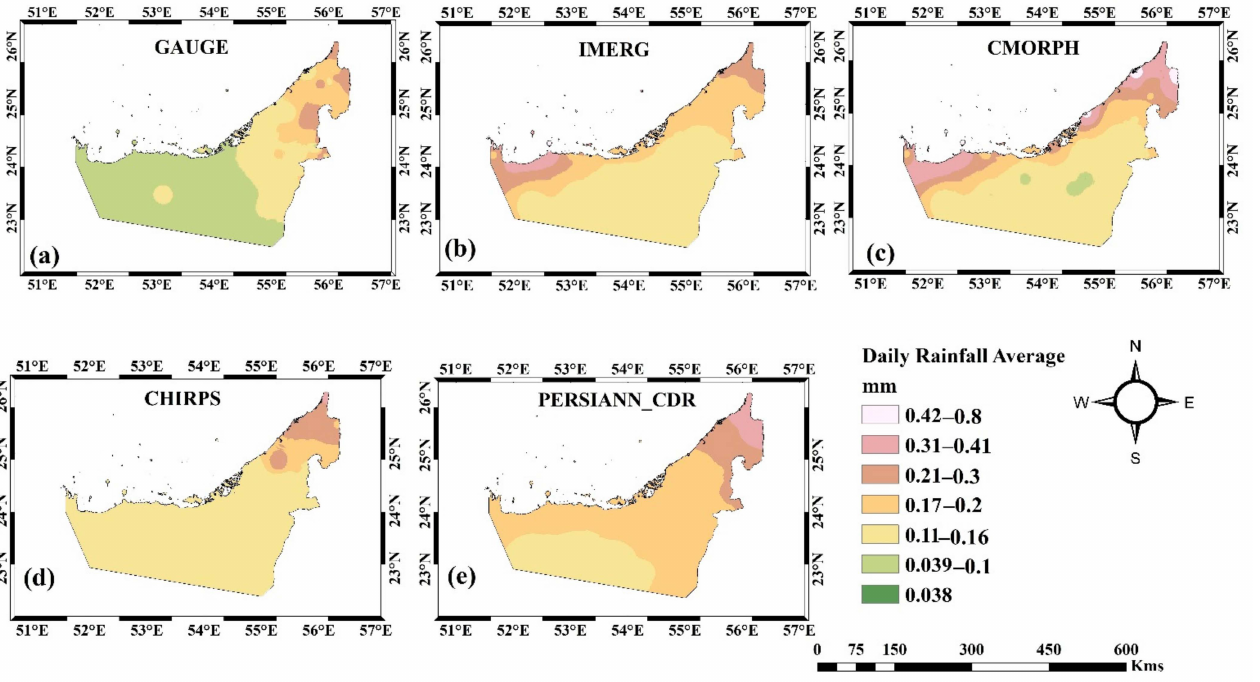
Figure 4. Average daily rainfall distribution for the gauge observation ( a ), IMERG ( b ), CMORPH ( c ), CHIRPS ( d ), PERSIANN-CDR ( e ).